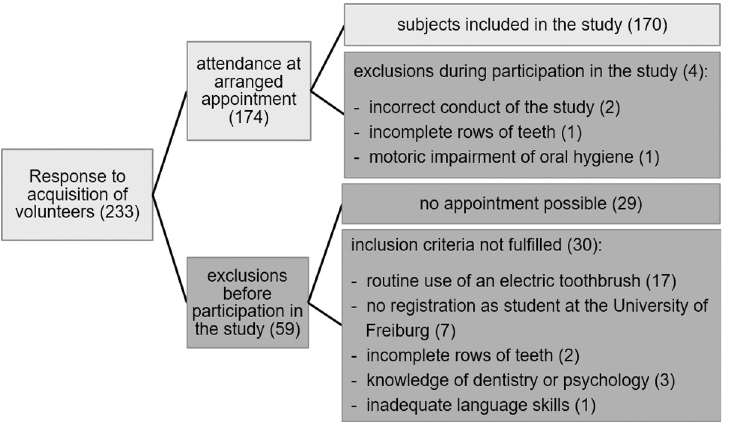
Fig 1. Flow-chart of number and reasons for inclusion or exclusion of participants prior to and during the study. Reasons and number (in brackets) of included or excluded participants.